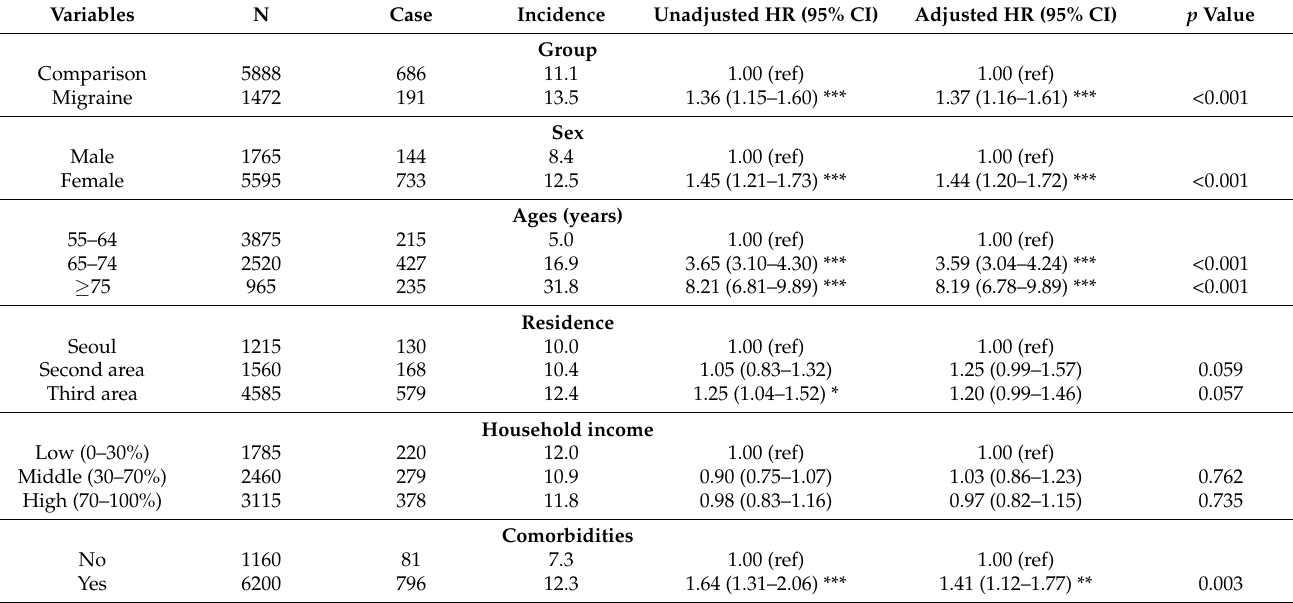
Table 2. Incidence per 1000 person-years and HR (95% CIs) of dementia between comparison (non-migraine) and migraine group.